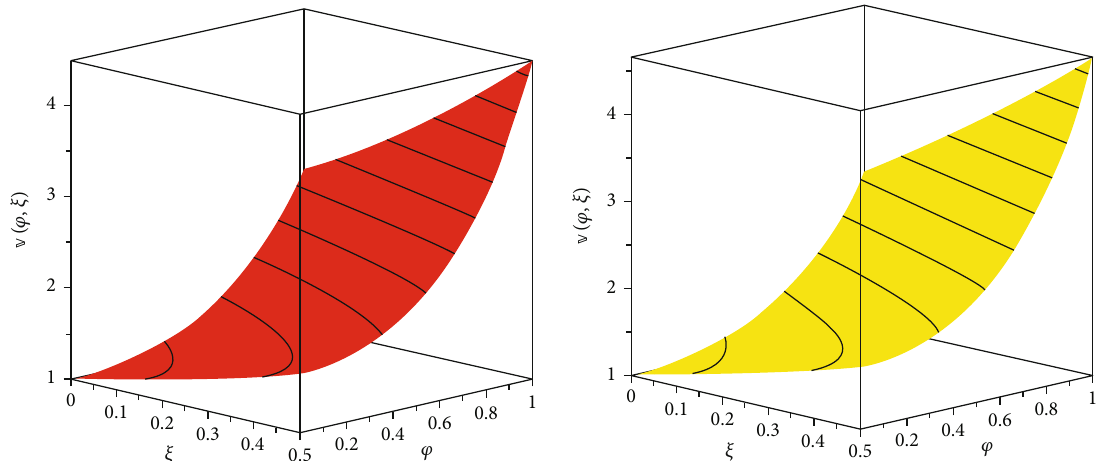
Figure 4: (a) ℘ = 1 and (b) the fractional-order ℘ = 0 : 8 of Example 10.